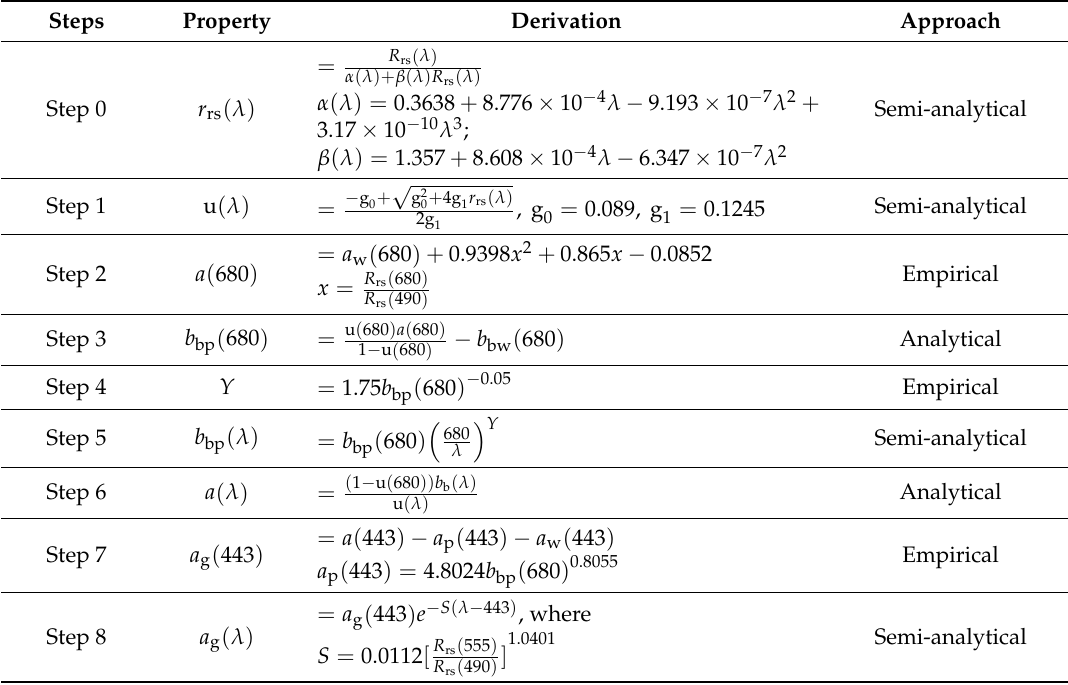
Figure 5. Scatter plot of in situ a p (443) values plotted versus b bp (680) values. Table 3. A QAA_cj algorithm’s calibration for the Changjiang estuarine and coastal